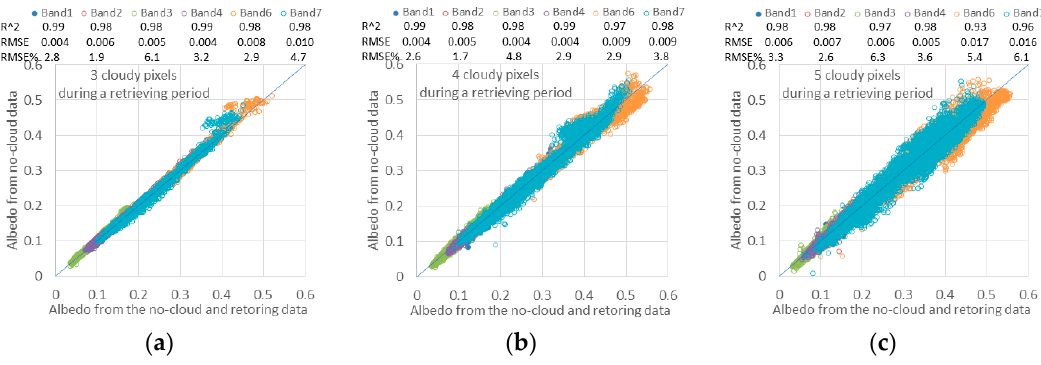
Figure 11. 2D scattering plots of the band white-sky albedo retrieved from no-cloud data and mixed data including no-cloud and restored cloudy pixels according to the different number of the cloudy pixels: ( a ) 3; ( b ) 4; and ( c ) 5.